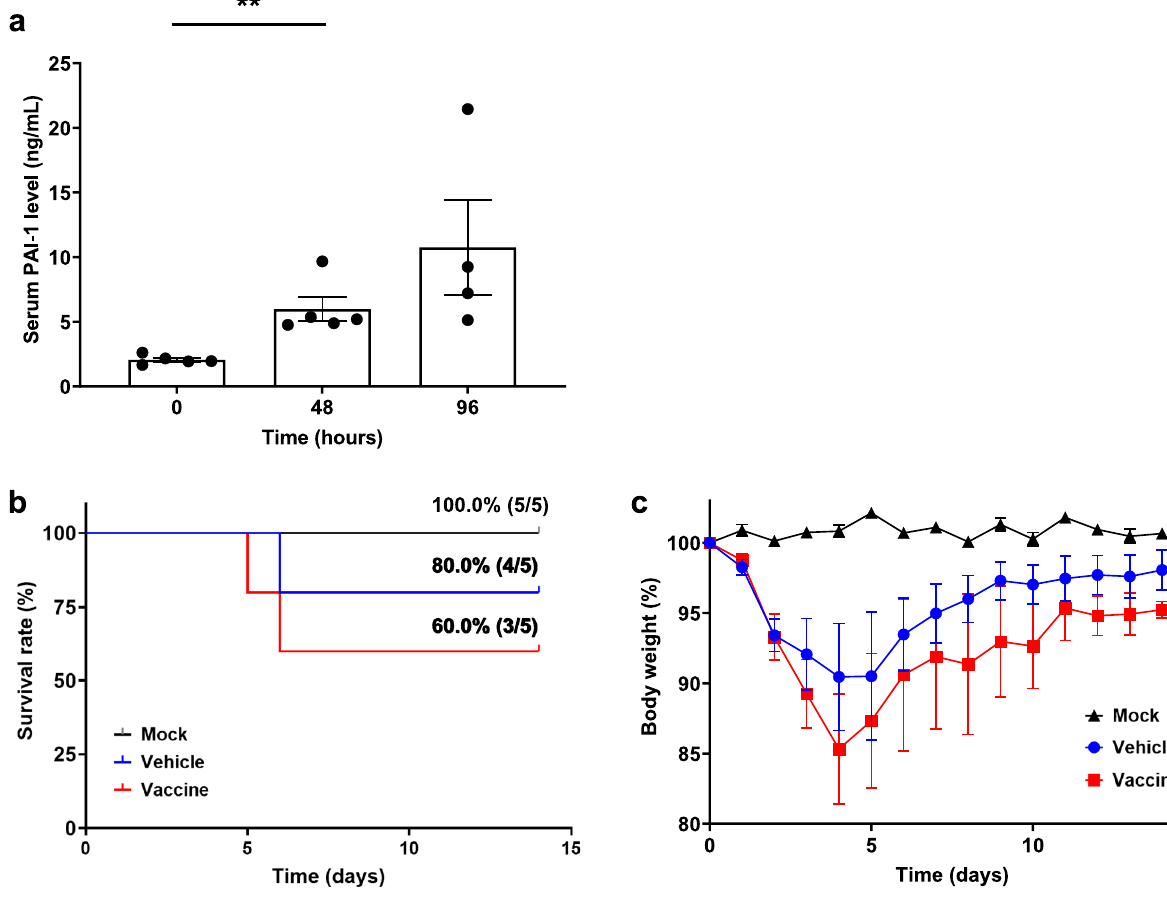
Figure 5. Effects of PAI-1 vaccine on survival and body weight change in a mouse model of SARS-CoV-2 infection. ( a ) Serum samples were obtained from non-immunized mice ( n = 4 or 5 per group) before and at 48 and 96 h after intranasal infection with mouse-adapted SARS-CoV-2, and serum PAI-1 levels were measured. ( b ) The survival and ( c ) body weight of mock-infected mice and SARS-CoV-2-infected mice immunized with PAI-1 vaccine or KLH vehicle (n = 5 per group) were monitored for 14 days. Data are expressed as mean ± SEM (error bars). Significant differences in serum PAI-1 levels between before and 48 h after infection were determined by using Student’s t -test. ** P < 0.01 compared with the values before infection. Survival was visualized by using the Kaplan–Meier method. Differences in survival were evaluated with the log-rank test; differences in body weight were determined by using a linear mixed-effects